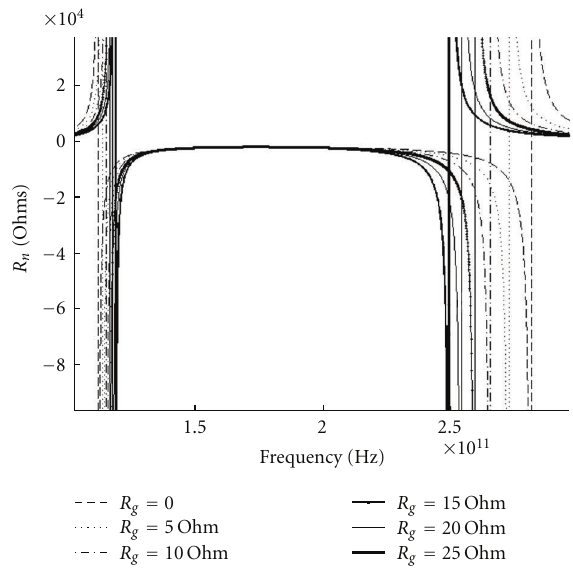
Figure 6: Variation of R n with gate resistance R g .